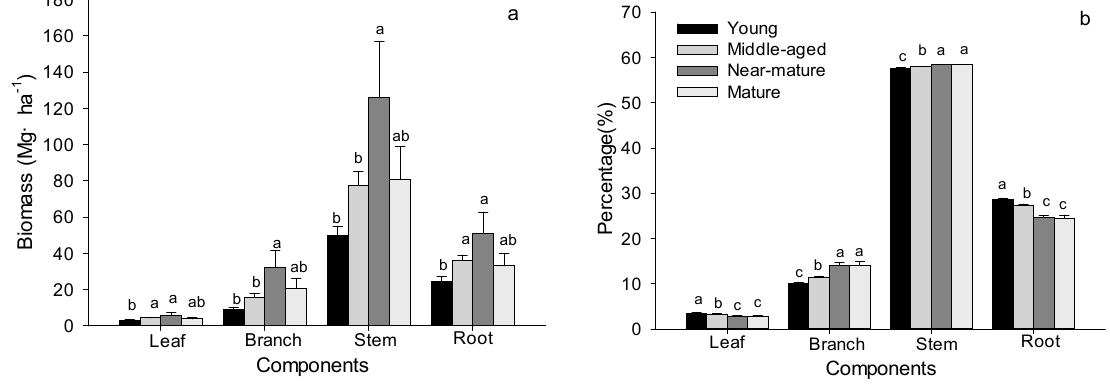
Figure 5. Biomass and the distribution of tree components in Quercus variabilis stands (Means ± SE, n = 8, 6, 3 and 3 for young, middle-aged, near-mature and mature stands, respectively). ( a ) Biomass of each component; ( b ) percentage of biomass. Different small letters indicated significant difference in the same indicators among different forest age classes.